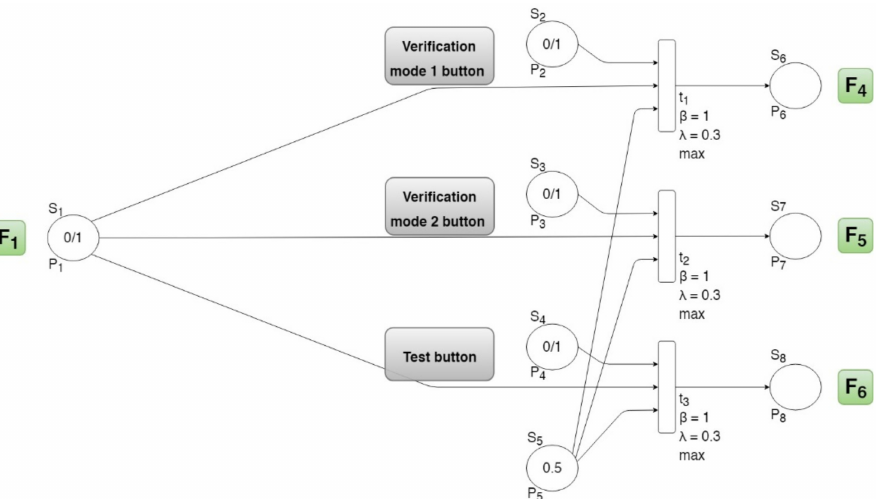
Figure 6. A graphical structure of the fuzzy Petri net algorithm for the transition between the normal production mode (F1) and the different verification and test modes of the